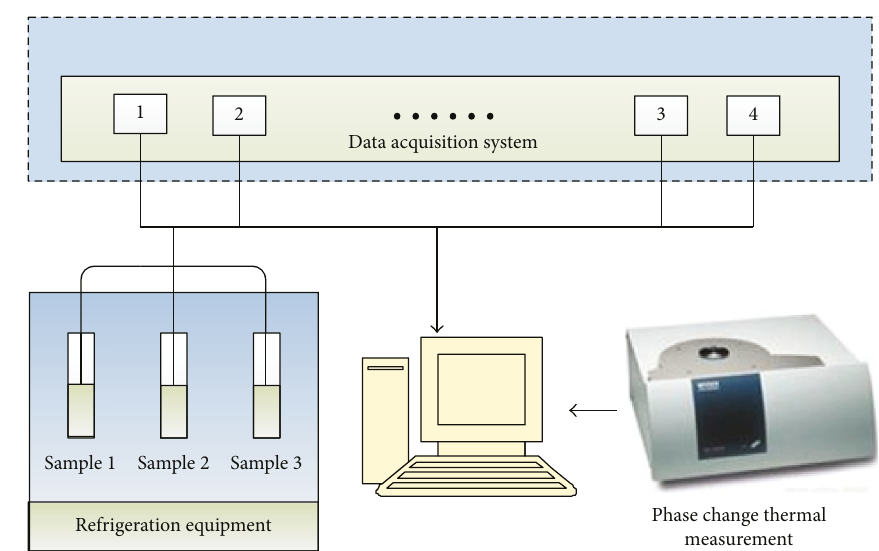
Figure 2: Schematic diagram of the experimental system.